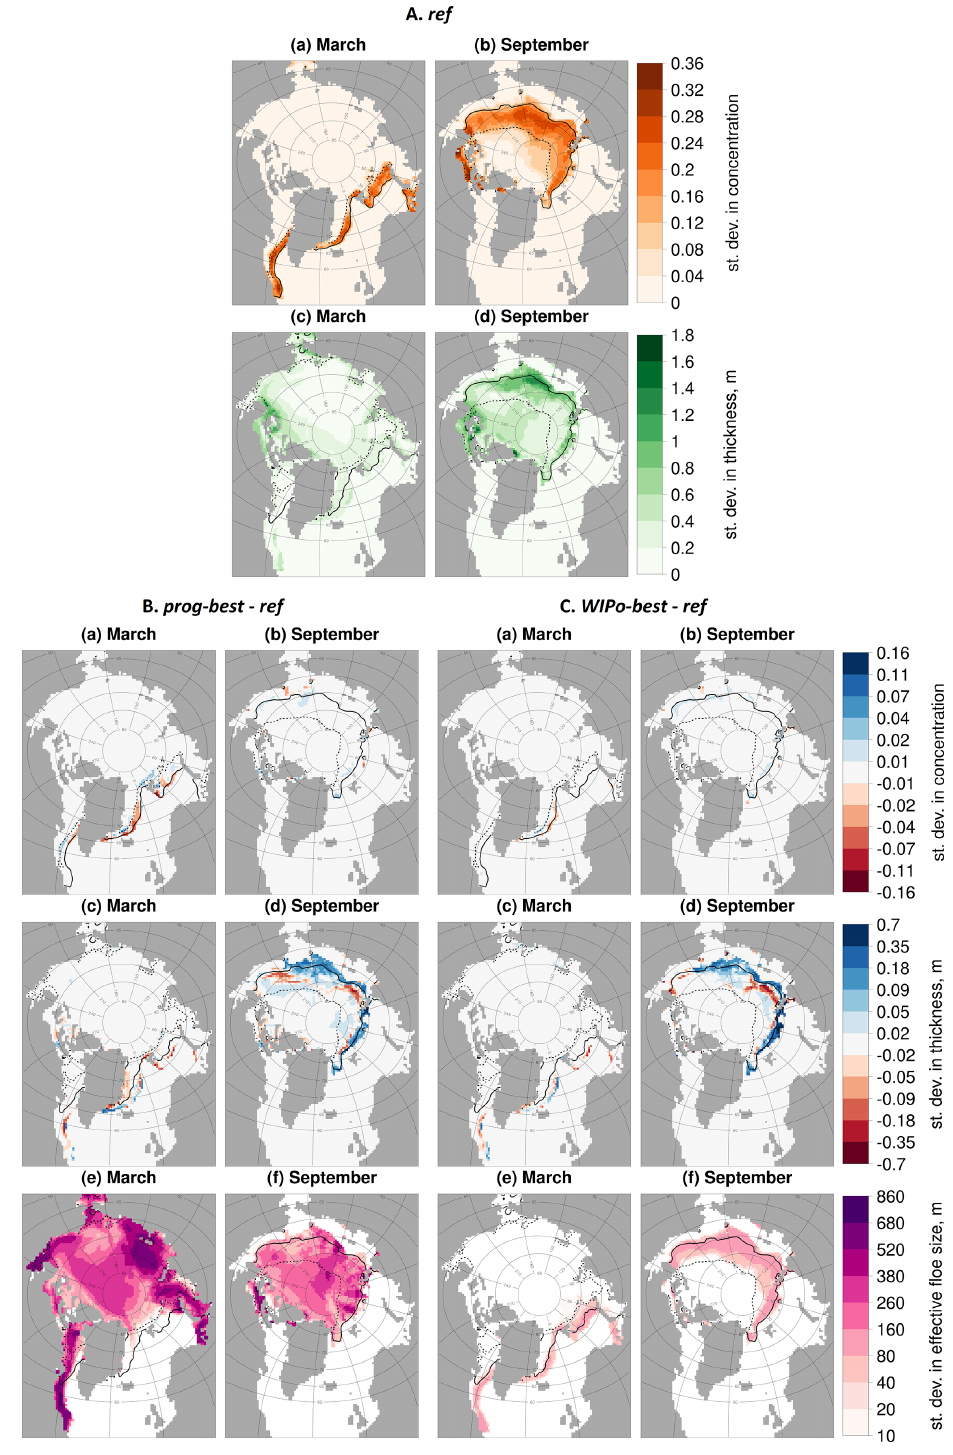
Figure 11. Section A (top) shows the standard deviation of the sea ice area fraction (a, b) and thickness (c, d) in March (a, c) and September (b, d) for ref. Sections B (bottom left) and C (bottom right) show difference plots in the standard deviation of the sea ice area fraction (a, b) and thickness (c, d) in March (a, c) and September (b, d) for prog-best and WIPo-best relative to ref respectively. In B and C, the standard deviation in l eff is also plotted for both March (e) and September (f) . Values are shown only in locations where the sea ice concentration exceeds 5%. The inner (dashed black) and outer (solid black) extent of the MIZ averaged over the same period is also shown. Plots show that changes to the standard deviation in the sea ice area fraction and thickness are generally localised to the outer edge of the MIZ.